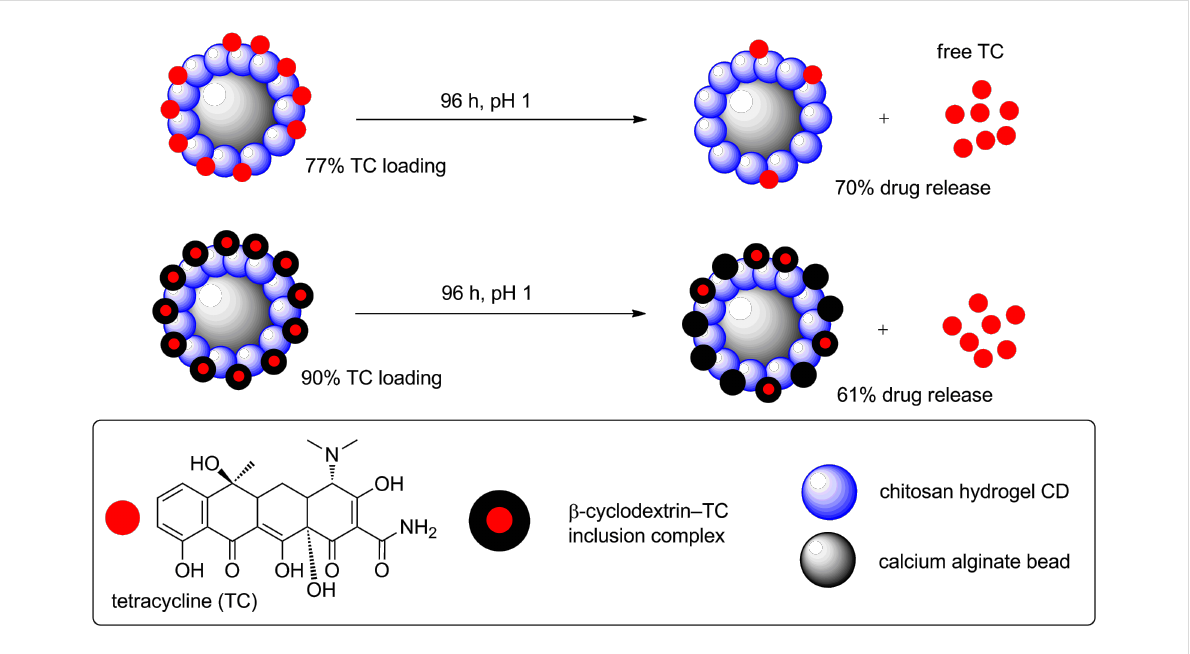
Scheme 21: Tetracycline release profiles for differentially-decorated